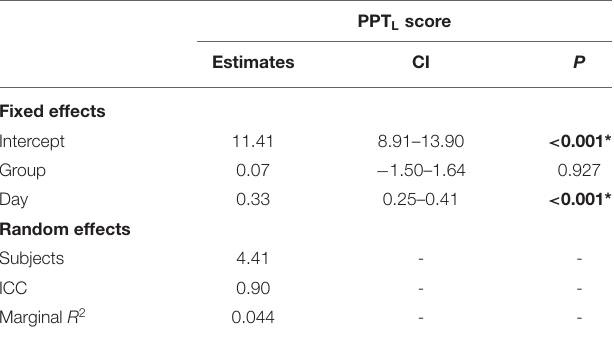
TABLE 3 | Results of linear mixed effects model examining motor learning over 5 days of skill training. PPT L score Estimates CI